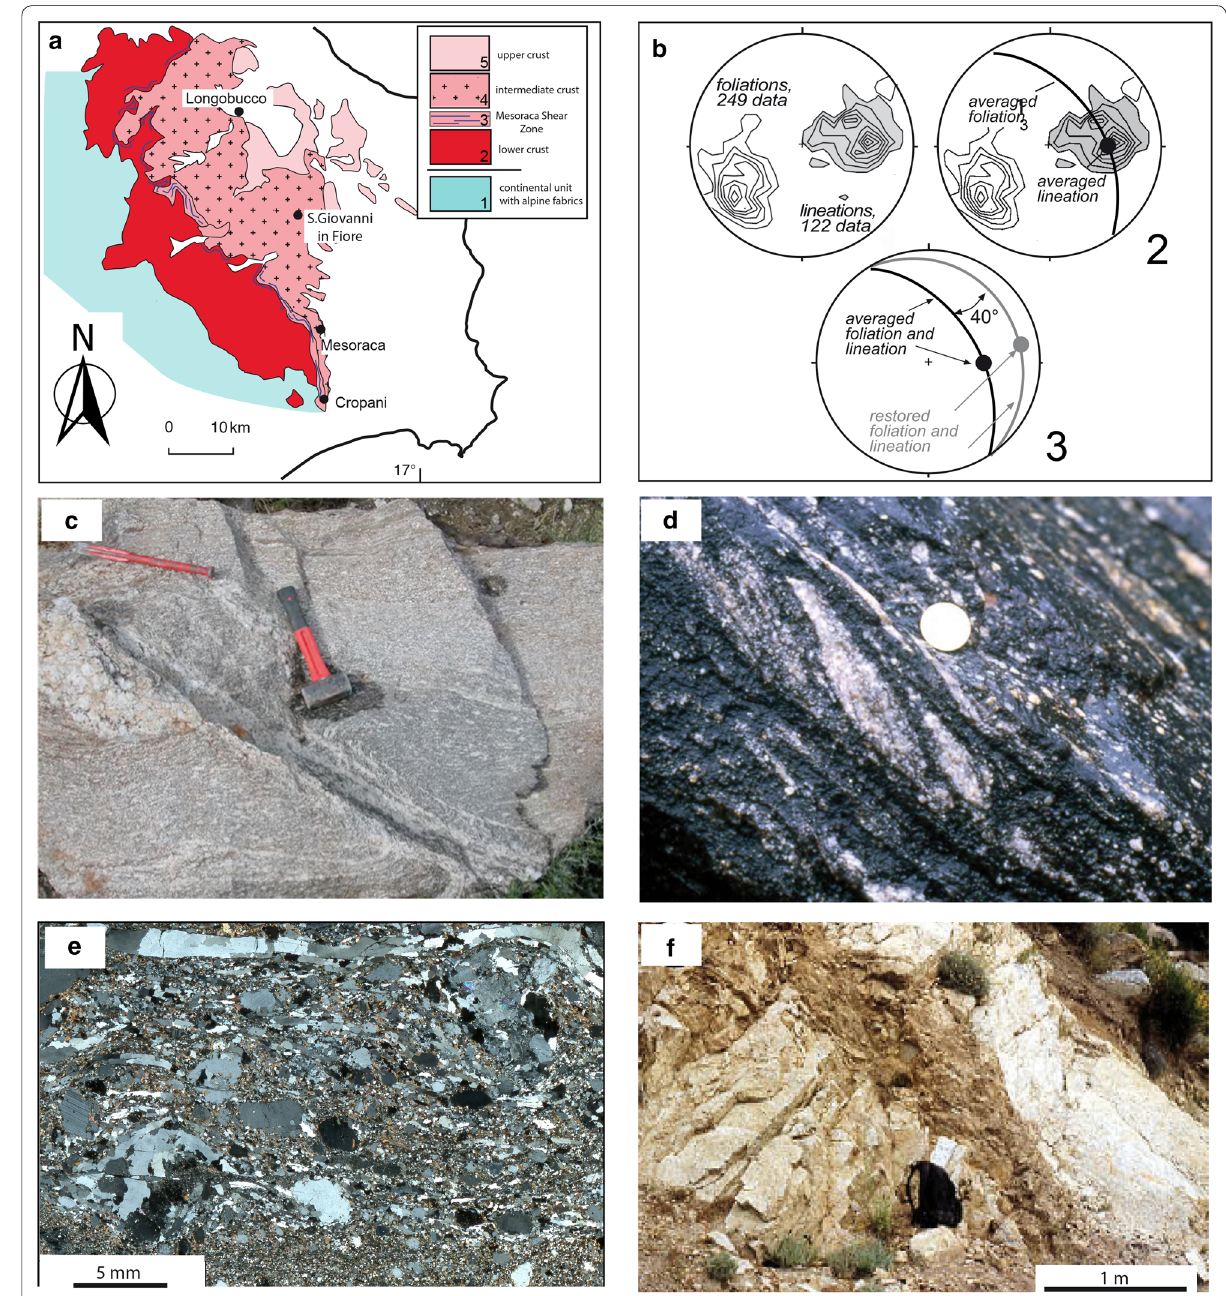
Fig. 8 a Sketch map of the Sila Massif: (1) continental unit affected by pervasive Tertiary orogenic fabrics; (2) lower crustal section (high grade metamorphic rocks), (3) Mesoraca Shear Zone, (4) intermediate crustal section (leucogranite, gabbro-diorite; metaluminous to strongly peraluminous granite and granodiorite); (5) upper crustal section of low grade metamorphic rocks. b Equal area, lower hemisphere stereonets showing structural data of the Mesoraca Shear Zone. (1) Poles of the main foliation and mineral and/or stretching lineation in migmatitic paragneiss, foliated granodiorite and mylonites. Contouring of lineation and foliation data indicated by grey and white areas, respectively; contouring interval (2%) equals the maximum of the data distribution contoured at > 16%; (2) best fit of foliation and lineation data; (3) back-rotation of the averaged mean foliation and lineation obtained by assuming a horizontal rotation axis parallel to the strike of the mean foliation (details in Liotta et al. 2008). c Melt-present deformation structures in granodiorites representing the early stages of Mesoraca Shear Zone deformation; d S/C structures indicating a top-to-the-west sense of shear in mylonites of the Mesoraca Shear Zone; e thin section scan (crossed polars) of a granodiorite involved in the Mesoraca shear zone. Quartz ribbons and porphyroclasts of quartz and feldspars locally showing core and mantle structure can be observed; f undeformed pegmatite and porphyritic dyke, intruding wall-rocks and the previously emplaced granitoids, respectively. The dyke (dated between c.290–280 Ma in Liotta et al. 2008) is exposed close to the Arvo